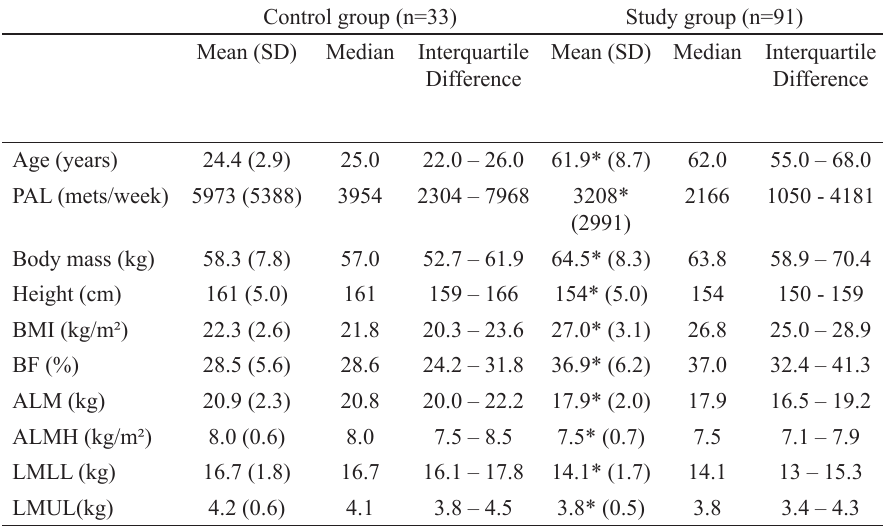
Table 1. Characteristics of the study samples and comparisons between control and study groups.